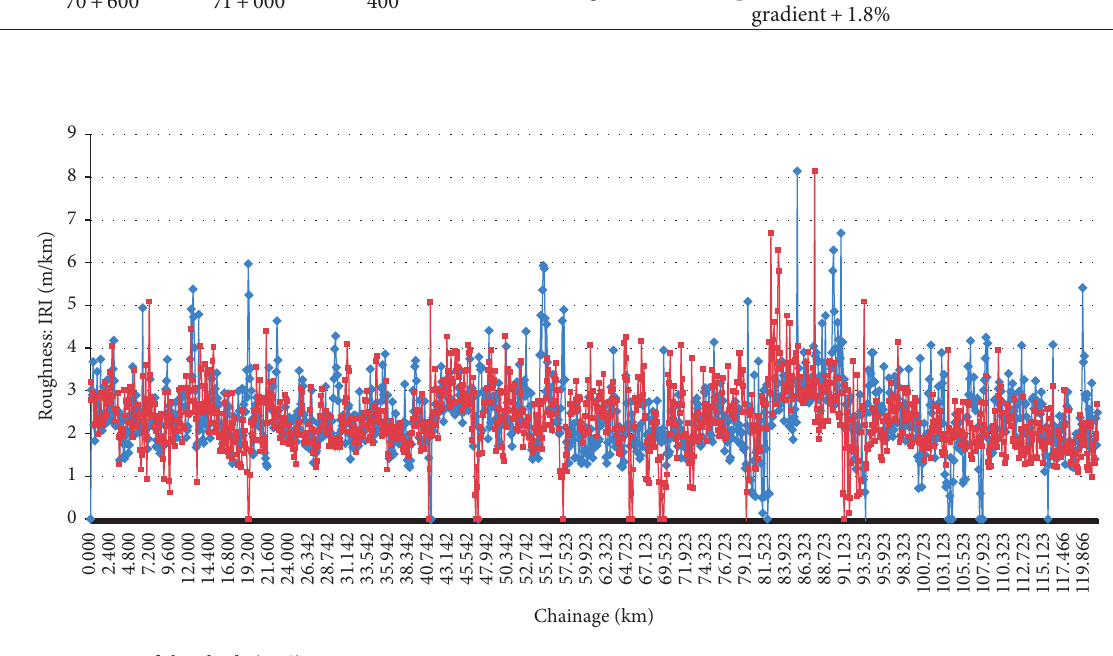
Figure 1: Roughness trend along the